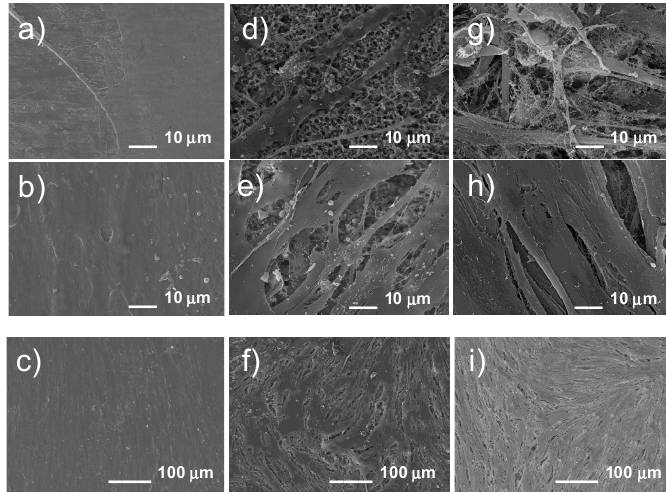
Figure 10. Osteoblast culture on the surface of the Ti23Mo 3BG nanocomposite before etching ( a , b , c ), after etching ( d , e , f ) and after etching with additional Ca-P deposition ( g , h , i ) after 1st ( a , d , g ) and 5th day (( b , c ), ( e , f ) and ( h , i )—different magnifications).